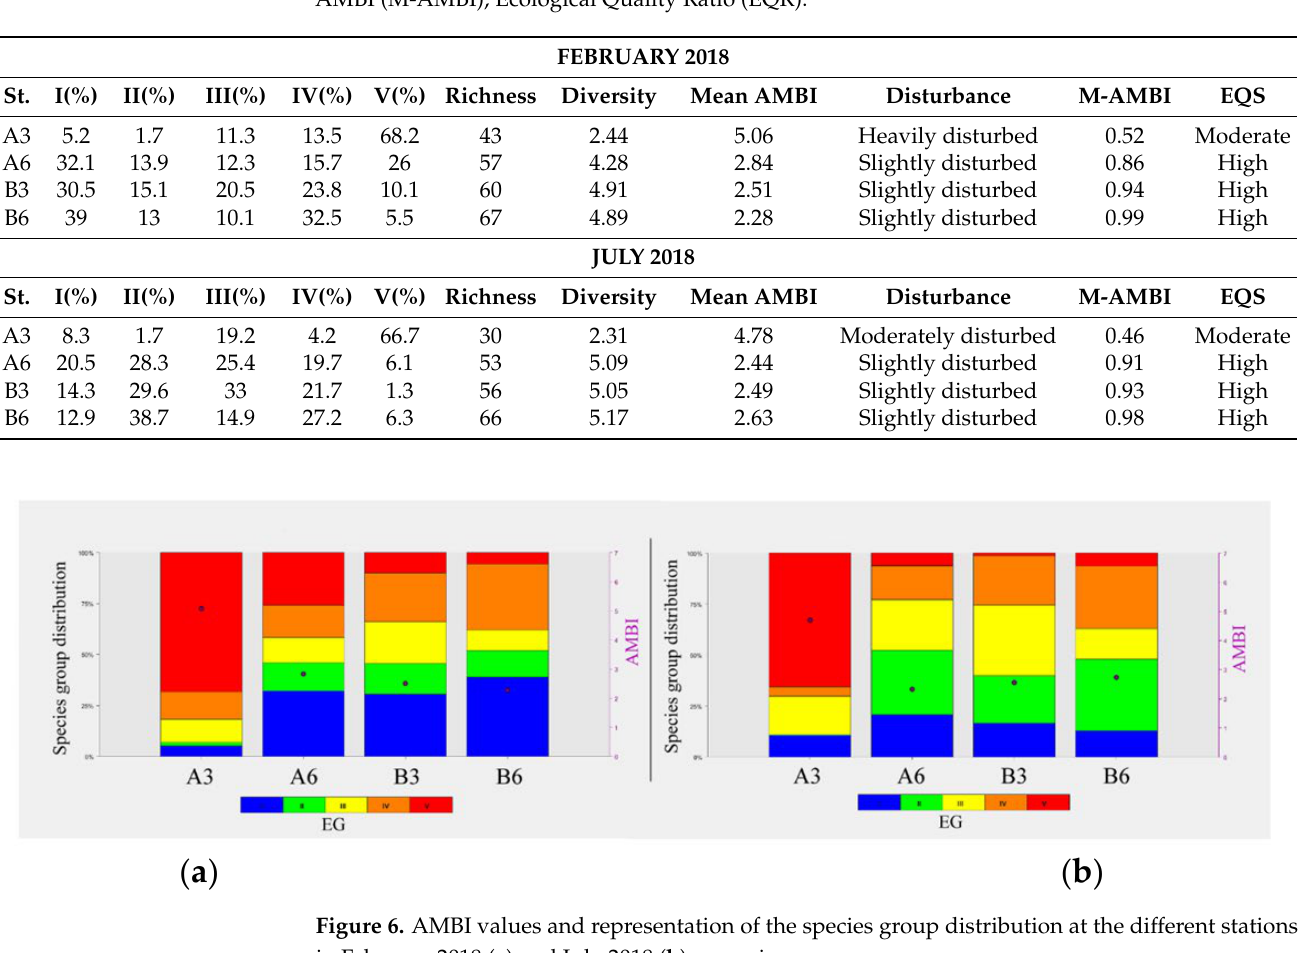
( b ) Figure 7. M-AMBI values and respective ecological status relative to the 4 examined sites in Febru- ary ( a ) and July ( b ) (modified from [28] with permission from IEEE, 2022, Copyright Clearance Cen- ter’s RightsLink ® ). 3.3. Multivariate Analysis Both trophic state and biological parameters were considered for water environ- ments, and only the latter for the benthic environment. The results from water parameter analysis showed B3 as the site that was least subjected to pollution. In contrast A3 was found to be the most impacted site (Figure 8a), with most of the measured parameters located close to the latter station, except for coliforms, which appeared to be more closely related to Station B6, and potential pathogens with A6. A similar trend was also observed in the CAP analysis relative to the sediment samples, but, showing an inverse trend, with potential pathogens more closely linked to Station B6 and coliforms to A6 (Figure 8b). In both compartments, however, the measured parameters indicated the existence of a clear gradient of impact related to farm production proceeding from the coast (B Zone) which includes Sites B6 and B3, to Sites A6 and A3 (A Zone) suggesting a presumable accumulation of organic matter under the cage located in the A Zone, especially at Site A3. Indeed, Sites A6 and A3 appeared to be characterized by a low environmental quality and, in particular, Station A3 seemed to represent the most impacted site due to the aqua- culture activities. In comparison, both B Stations were characterized by a higher environ- mental quality.